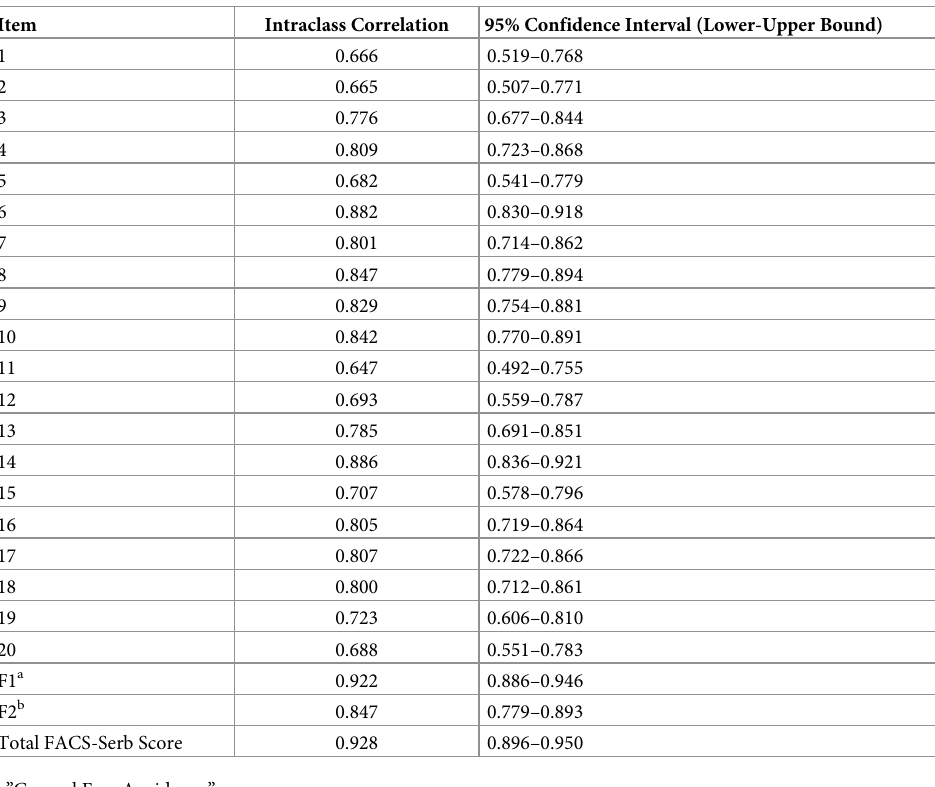
Table 1. Intraclass correlation coefficients and 95% confidence interval (Lower-Upper Bound) of Test-retest reliability.